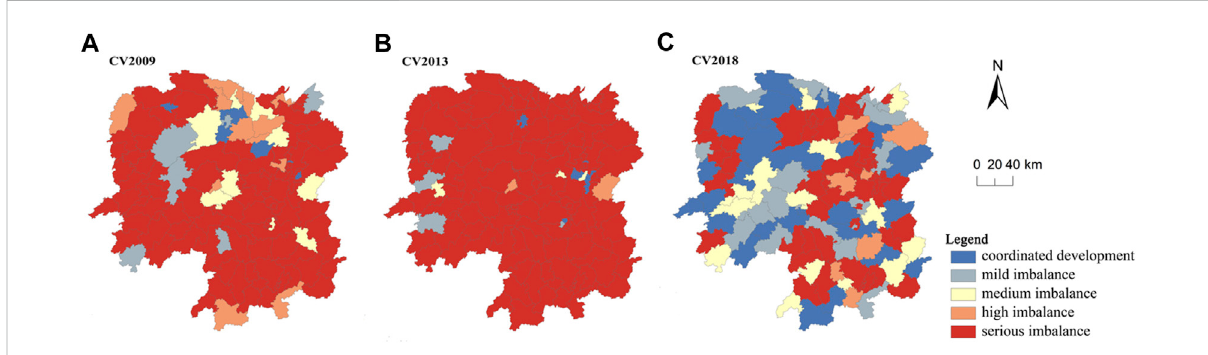
FIGURE 5 Spatial patterns of UCLUC in different periods. (A) Spatial patterns of UCLUC in 2009; (B) Spatial patternsof UCLUC in 2013; (C) Spatial patterns of UCLUC in 2018.